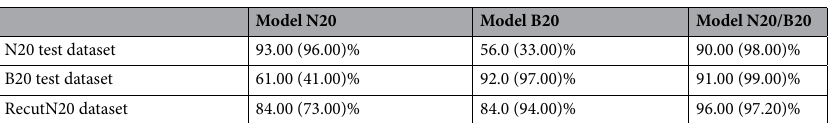
Table 2. MAP values of test results according to the different datasets of each model. The values in parentheses are masked mAP which calculated the accuracy of the mask region predicted by the model, compared to the ground truth